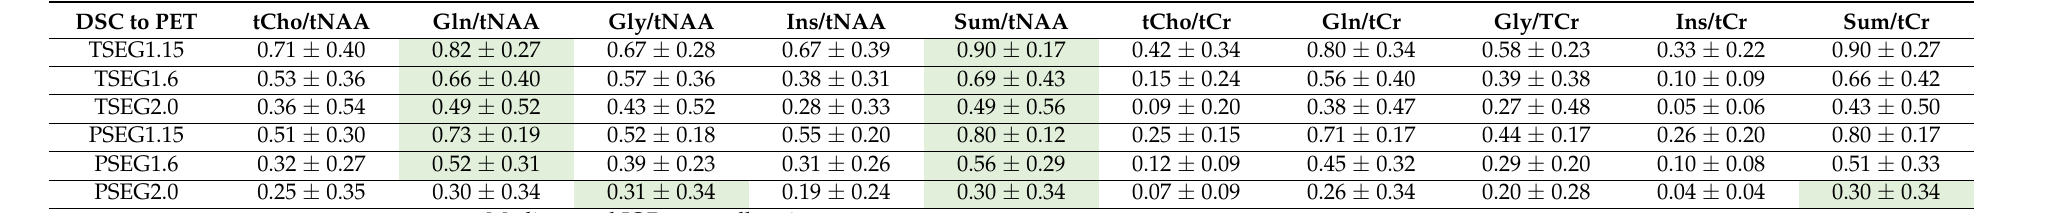
Table 2. DSCs to PET over all ratios and VOI thresholds.